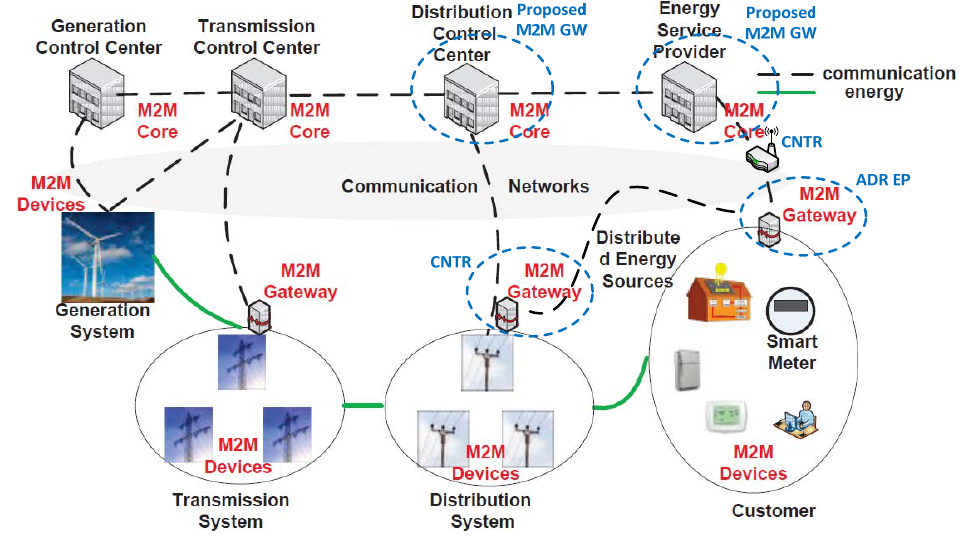
Figure 8. Mapping of the proposed M2M communications architecture onto the ETSI M2M architecture applied to the Smart Grid